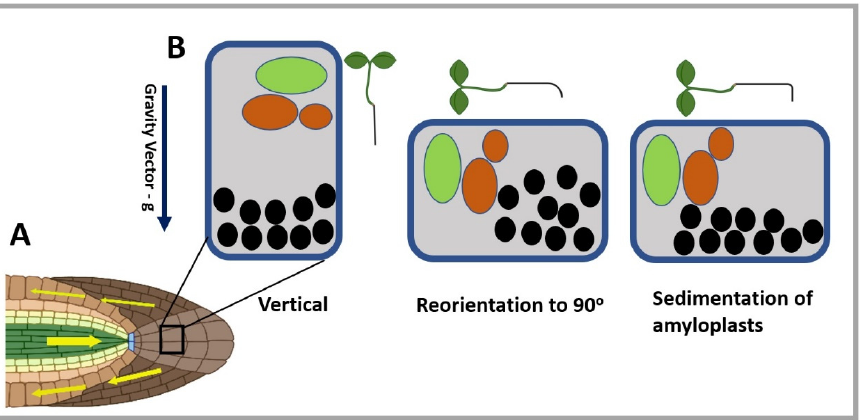
Figure 1. Representation of gravity-sensing according to the statolith hypothesis. (A) Root tip (primary site of gravity-sensing) representing the horizontal orientation of root and auxin flow. Yellow arrows show the auxin flow after stimulation by gravity. (B) Gravity-sensing in the columella cell (primary site of gravity-sensing or perception in the root) along the gravity vector, indicated by the blue arrow pointing downwards. On reorientation of the seedling, amyloplasts (black circles) sediment in the cell along the new gravity vector, causing the root bending. The green region represents the nucleus of the columella cell and the orange region the vacuoles. (Some segments of the figure were created with BioRender.com) (accessed on 02 June 2022). The role of auxin transport in gravitropism was underlined by applying the auxin transport inhibitor, NPA (naphthylphthalamic acid), preventing gravitropic root bending [26]. Secondary metabolites such as flavonoids act as endogenous negative regulators of auxin transport. The mutation transparent testa ( tt4 ) that disrupts a gene that encodes for chalcone synthase (CHS), the first enzyme of flavonoid biosynthesis, leads to an increase in root growth and gravitropism due to increment of auxin transport [27]. The tt4 mutants have substantially higher levels of transcripts of the PIN-FORMED (PIN) protein 2 (PIN2) than the wild type, which aids in basipetal auxin transport in the root [28]. Auxin and ethylene hormone interaction controls flavonol production via a signalling network in- volving TRANSPORT INHIBITOR RESPONSE1 (TIR1) and ETHYLENE INSENSITIVE2